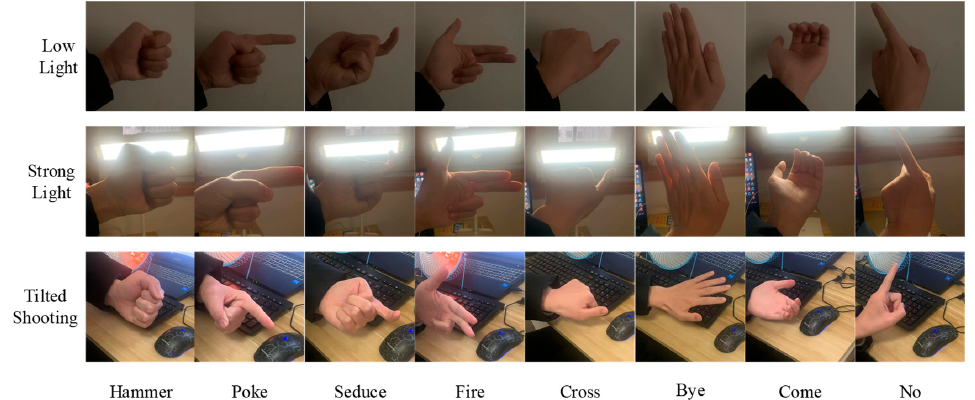
Figure 5. Illustration of the self-built dataset. (The first row represents low-light, the second row represents high-light, and the third row represents tilted shooting. Each column represents a category of hang gesture).